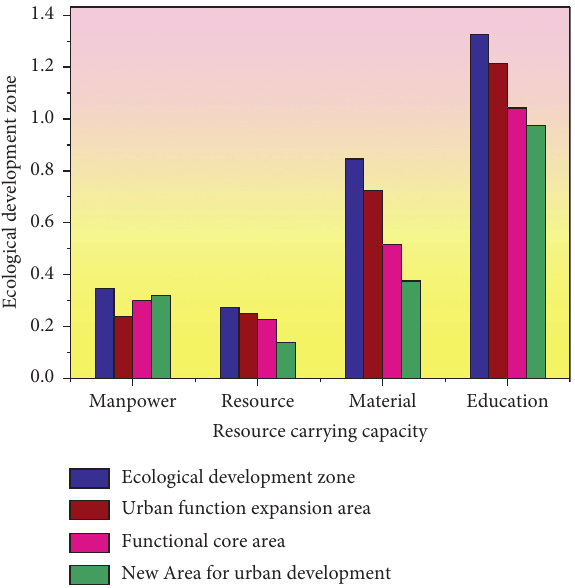
Figure 8: Spatial distribution difference diagram of bearing capacity.